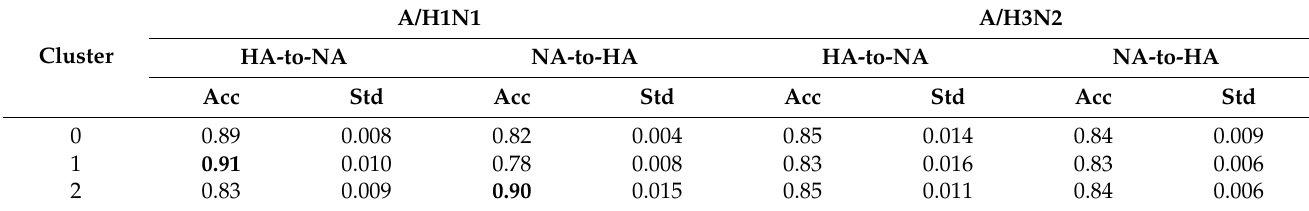
Table 3. Translation accuracies on other clusters of S2STM trained with strains in cluster-8–12.